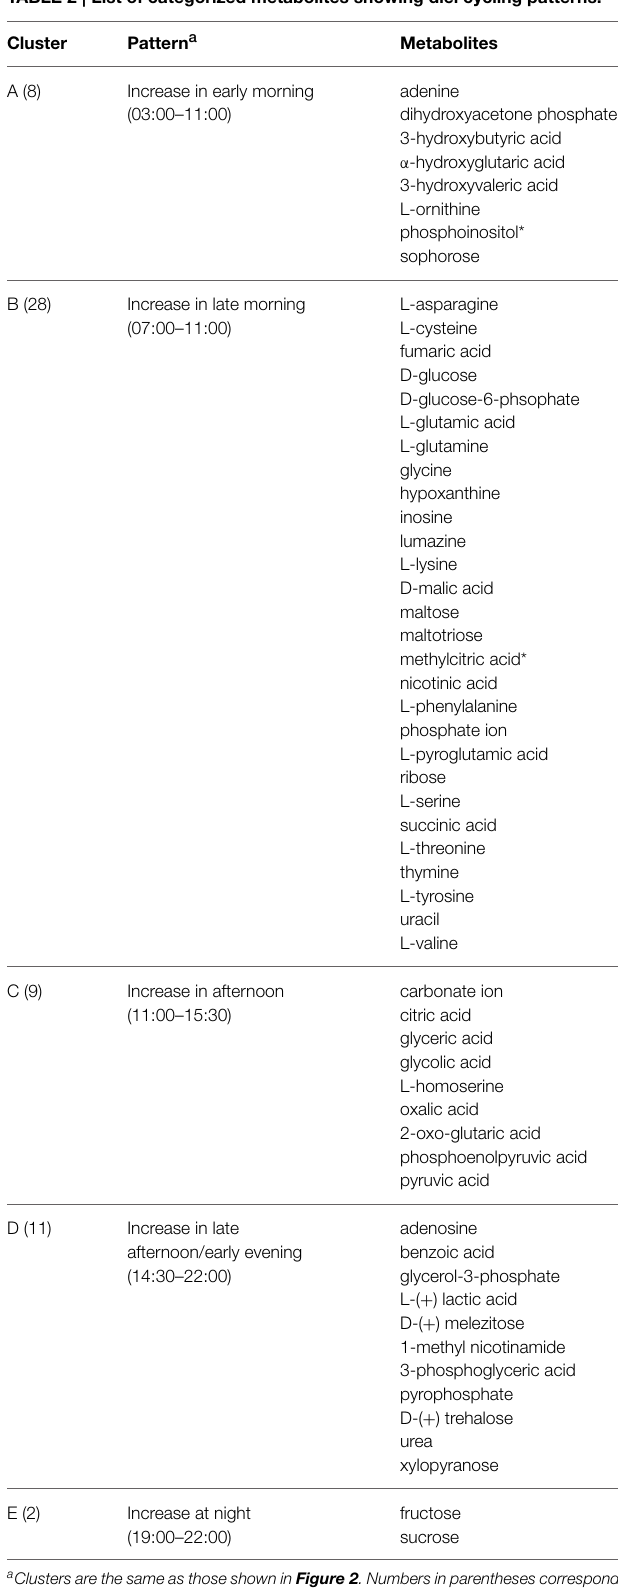
TABLE 2 | List of categorized metabolites showing diel cycling patterns. Cluster Pattern